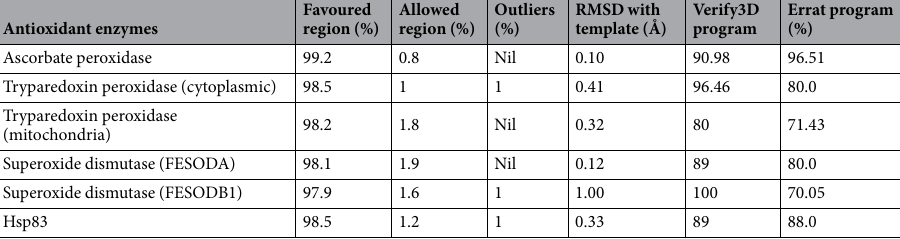
Table 2. Structure validation of the modeled structure of six antioxidant enzymes of L. donovani using different validation programs.